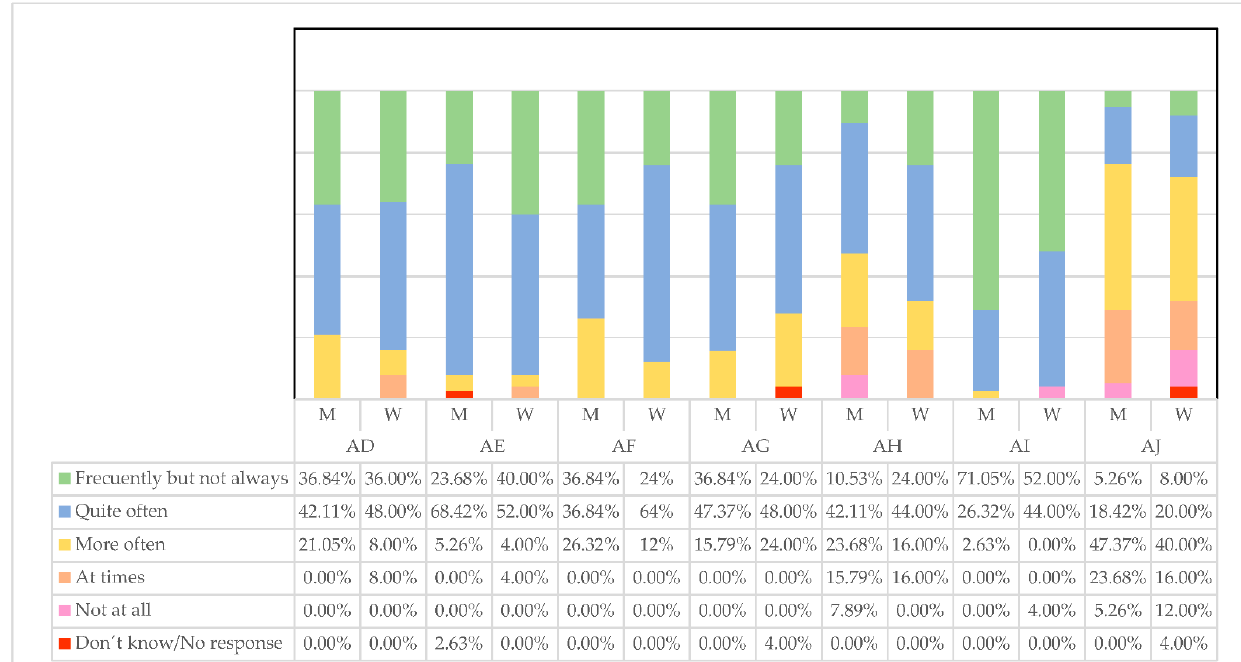
Figure 5. Qualities developed by managers. Source: Own elaboration.